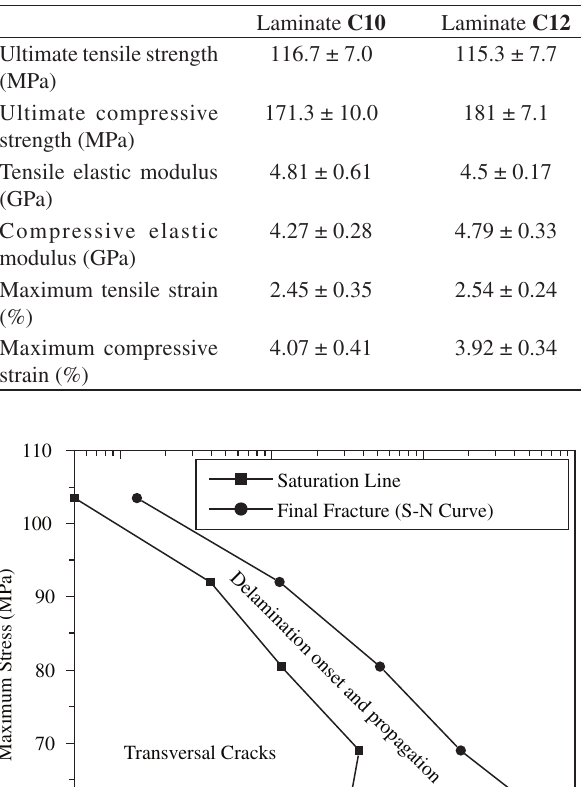
Table 1. Mechanical properties of laminates C10 and C12.